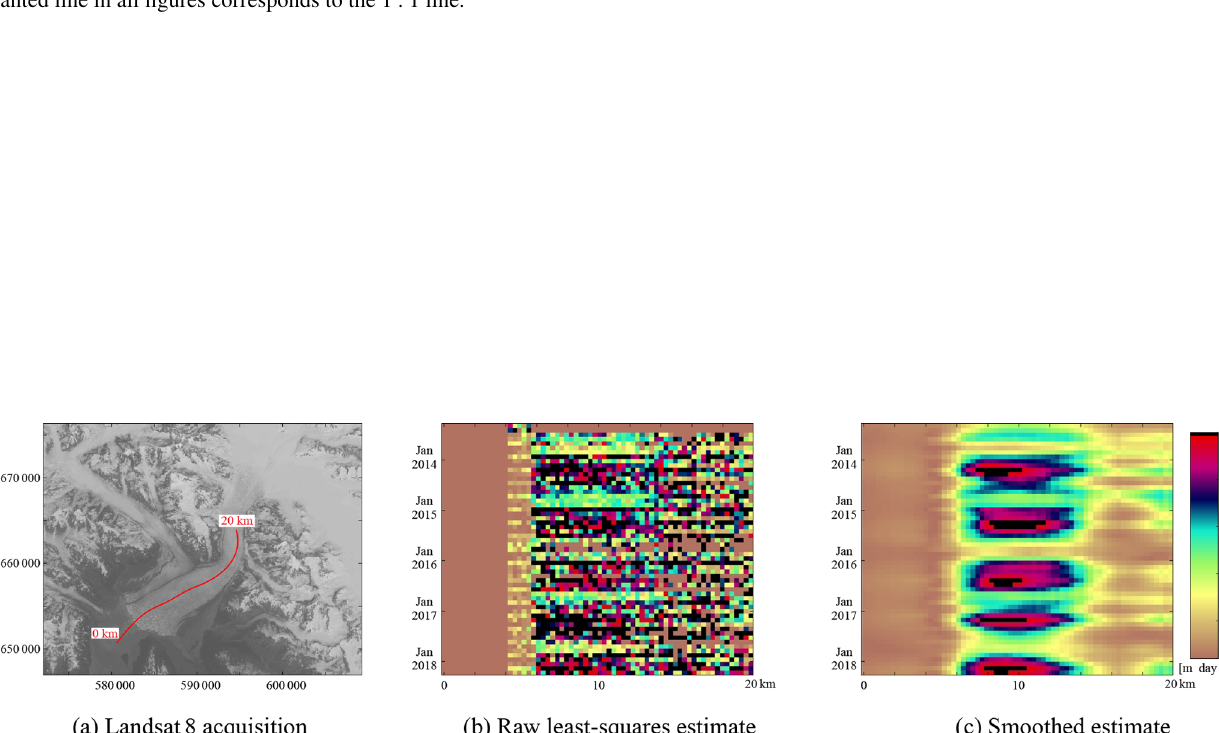
Figure B2. The temporal data shown in Fig. B1 are combined and the least-squares consensus is plotted against the smoothed estimate. The slanted line in all figures corresponds to the 1 : 1 line.